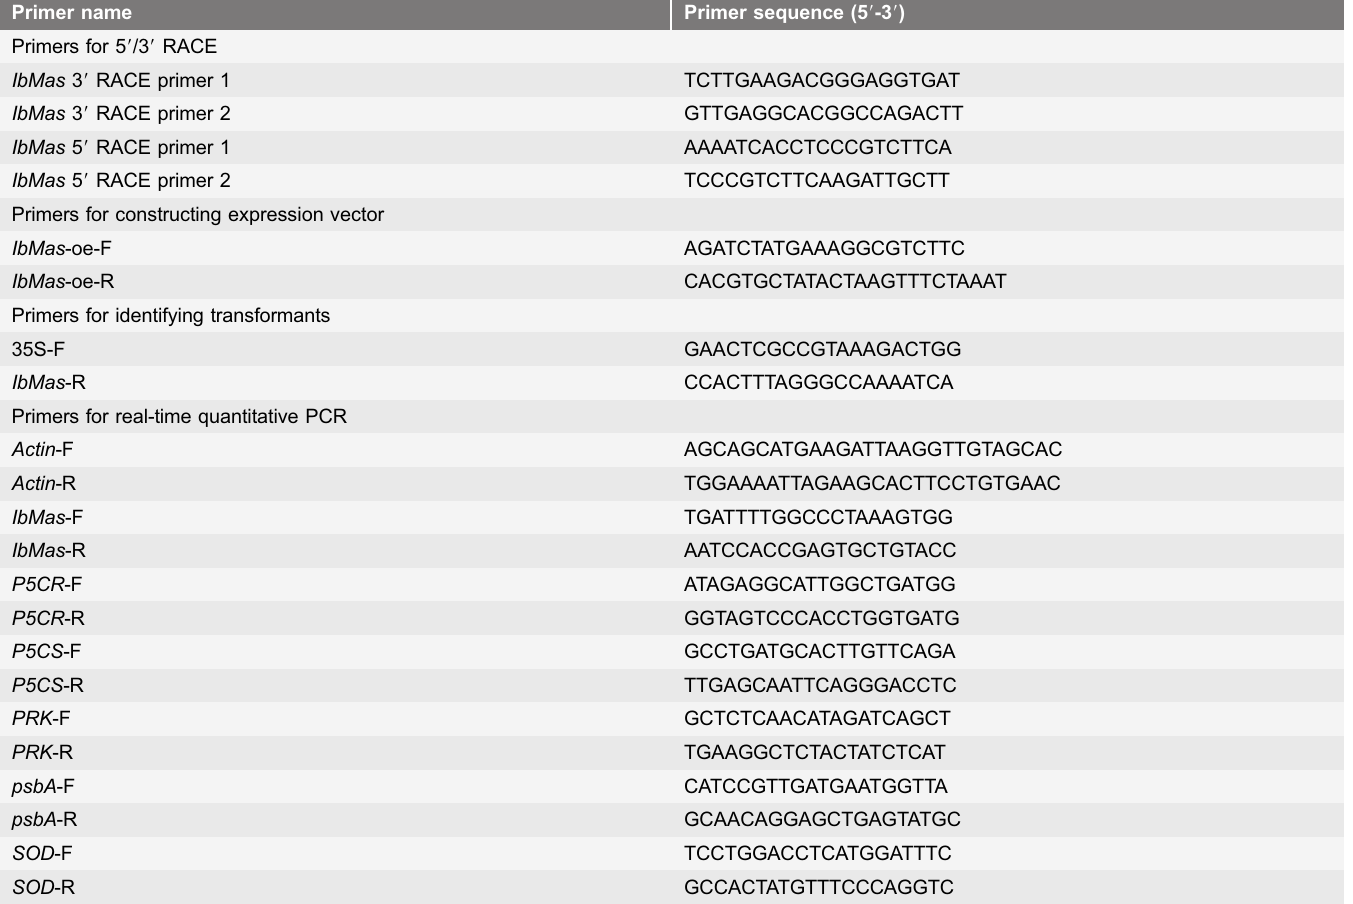
Table 1. Primers used in this